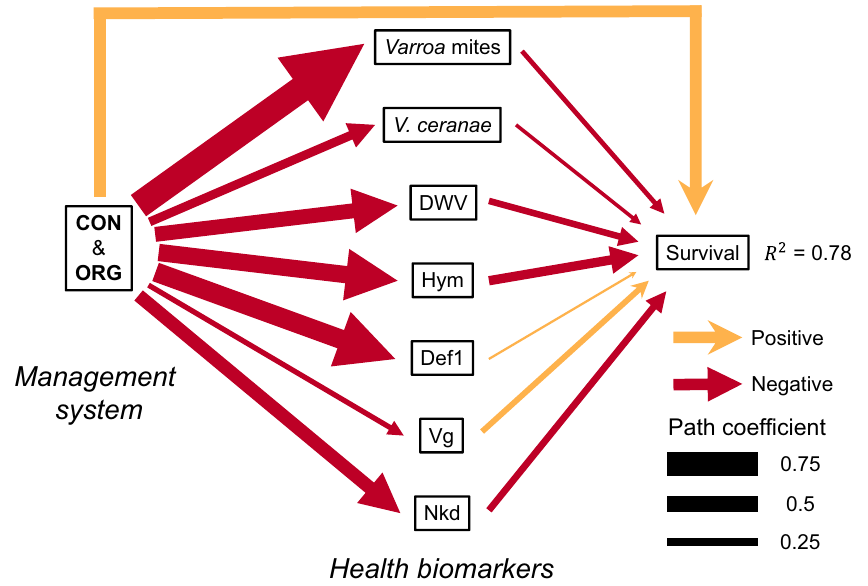
Figure 6. Path analysis showing the effects of management system (left) on health biomarkers (middle) and how they impact honey bee colony winter survival (right). Negative paths coming from the “CON & ORG” management system box indicate that the conventional and organic management systems reduced levels of variables compared to chemical-free treatments. Data used in the model treated apiaries as replicates (N = 72) and was averaged across 3 years of the study. Colors indicate positive (orange) and negative (red) effects. The width of the arrows is scaled by the path coefficients (ranging between 0 and 1) and indicates the strength of the association varying from low (thin) to high (thick). The arrow connecting management and survival shows the direct effect that is not explained by the intermediate health